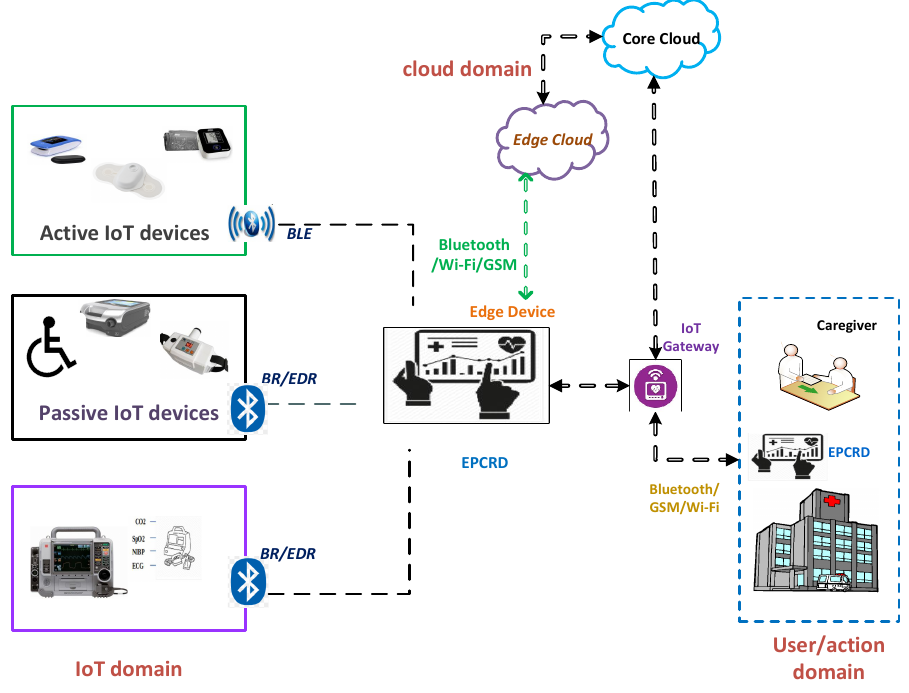
Figure 1. The use of Bluetooth and related protocols (BLE: Bluetooth low energy; BR/EDR: Bluetooth basic rate/enhanced data rate) in a typical smart healthcare system for communication between electronic patient care record device (EPCRD) and other entities over the edge and the